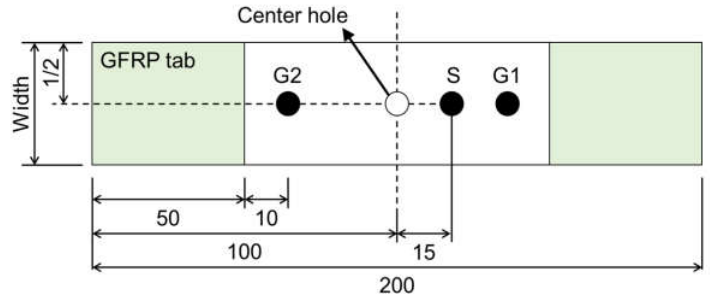
Figure 3. Schematic illustrations of fiber-reinforced plastic specimens with center hole and sensor locations (units in mm).